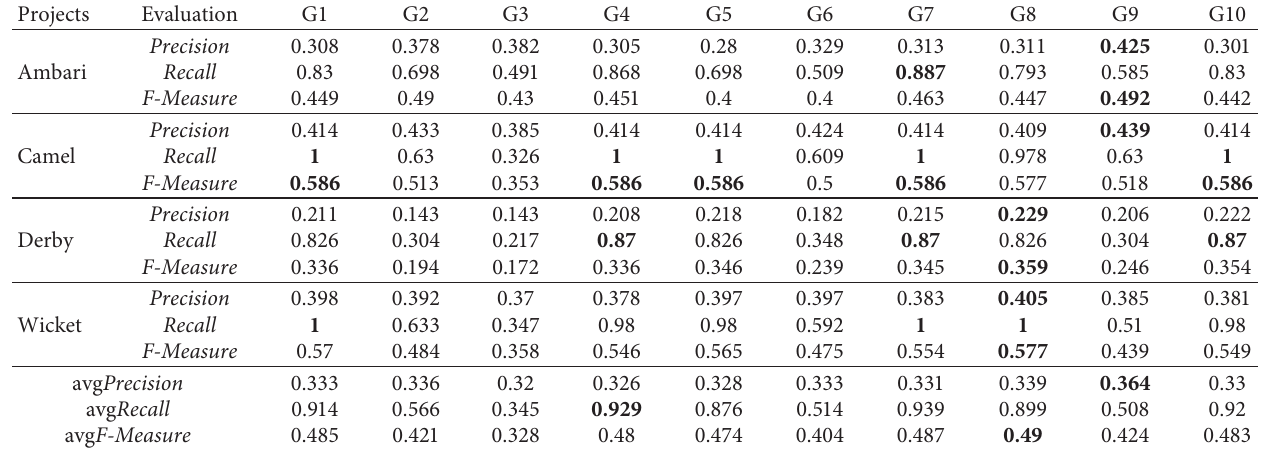
Table 6: The performance of 10 groups of classification